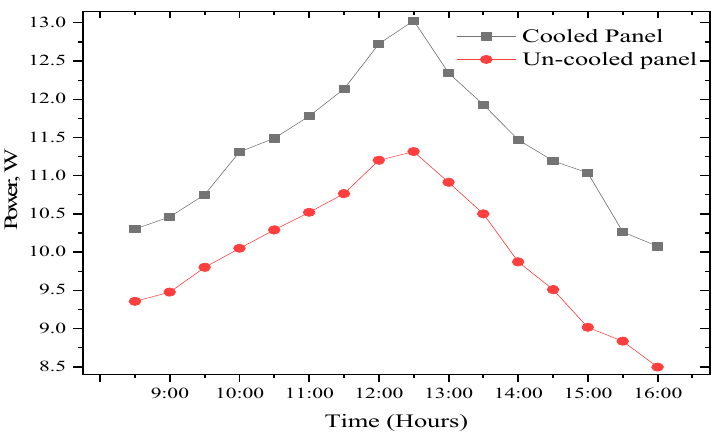
Figure 12. Time dependence of ( a ) Voltage and ( b ) Current of both PV panels.